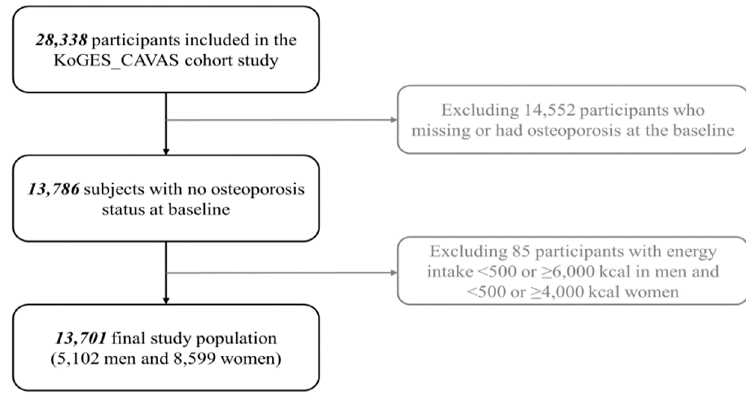
Figure 1. Flow chart of the study population. KoGES_CAVAS, Korean Genome and Epidemiology Study_Cardiovascular Disease Association Study.